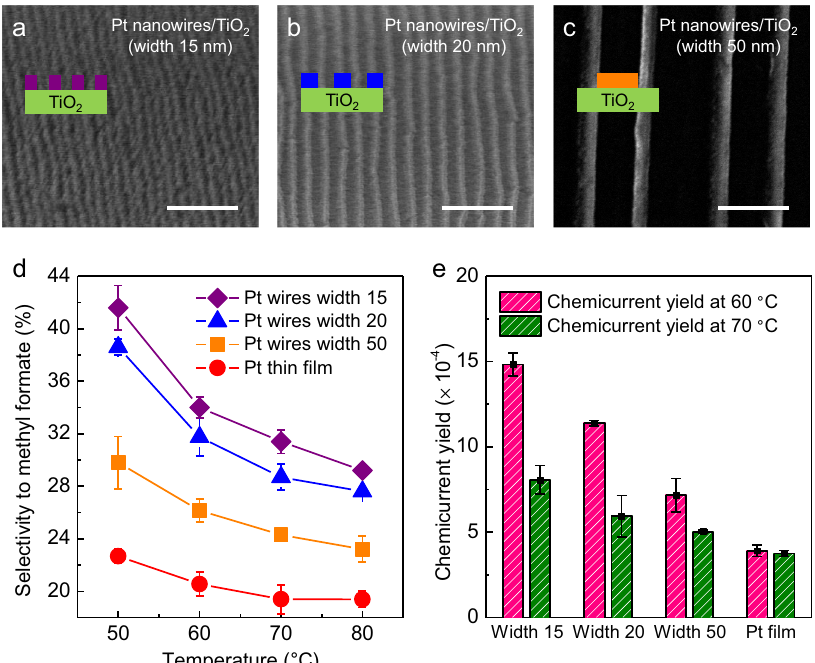
Fig. 3 Selectivity and chemicurrent yield on nanowire arrays with different widths. SEM images of a Pt nanowires/TiO 2 with a width of 15 nm, b Pt nanowires/TiO 2 with a width of 20 nm, and c Pt nanowires/TiO 2 with a width of 50 nm. Scale bars are 200 nm. d Selectivity to methyl formate under methanol oxidation on the Schottky nanodiodes at different temperatures with different widths. e Chemicurrent yield for methanol oxidation on the catalytic nanodiodes of width 15 (Pt nanowires/TiO 2 with a width of 15 nm), width 20 (Pt nanowires/TiO 2 with a width of 20 nm), width 50 (Pt nanowires/ TiO 2 with a width of 50 nm), and Pt fi lm (Pt fi lm/TiO 2 ) measured both at 333 and 343 K. All results were obtained under methanol 4 Torr and O 2 to 760